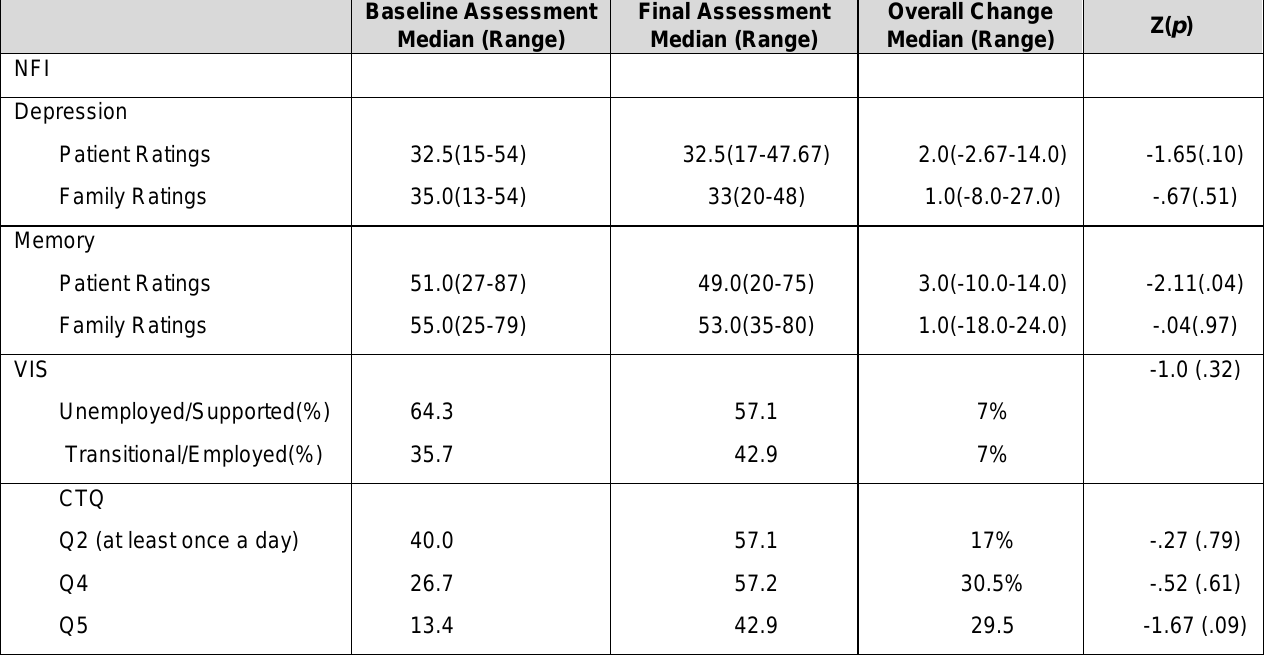
Table 5. Overall Treatment Effect: Baseline Assessment vs. Final Assessment